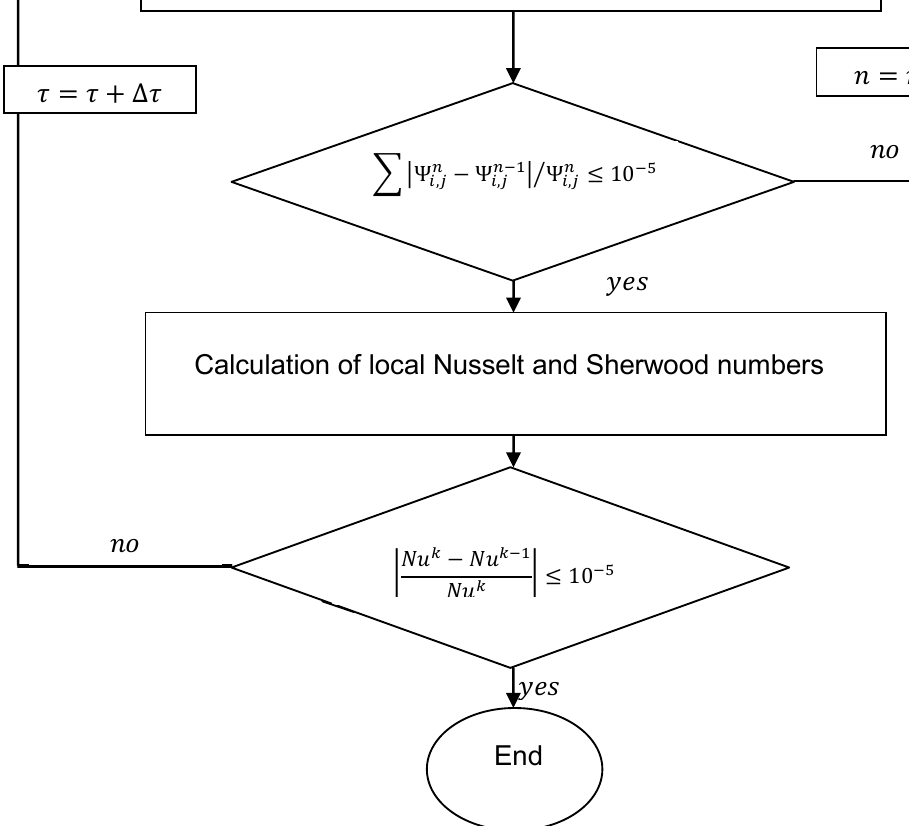
Figure 2 . Resolution